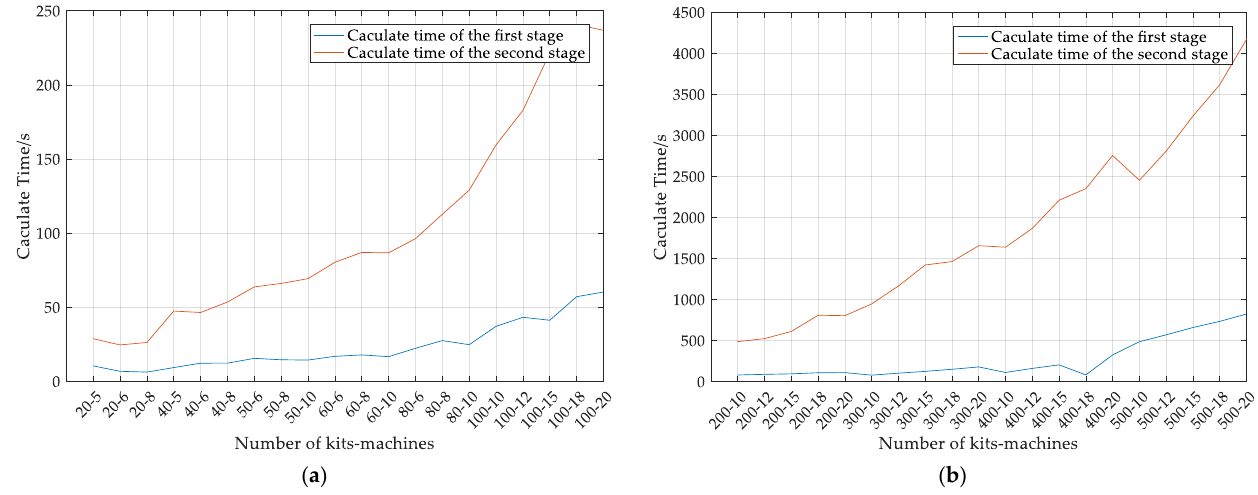
Figure 15. Comparison graph of solving time of the two stages. ( a ) Small-size instances; ( b ) large-size instances